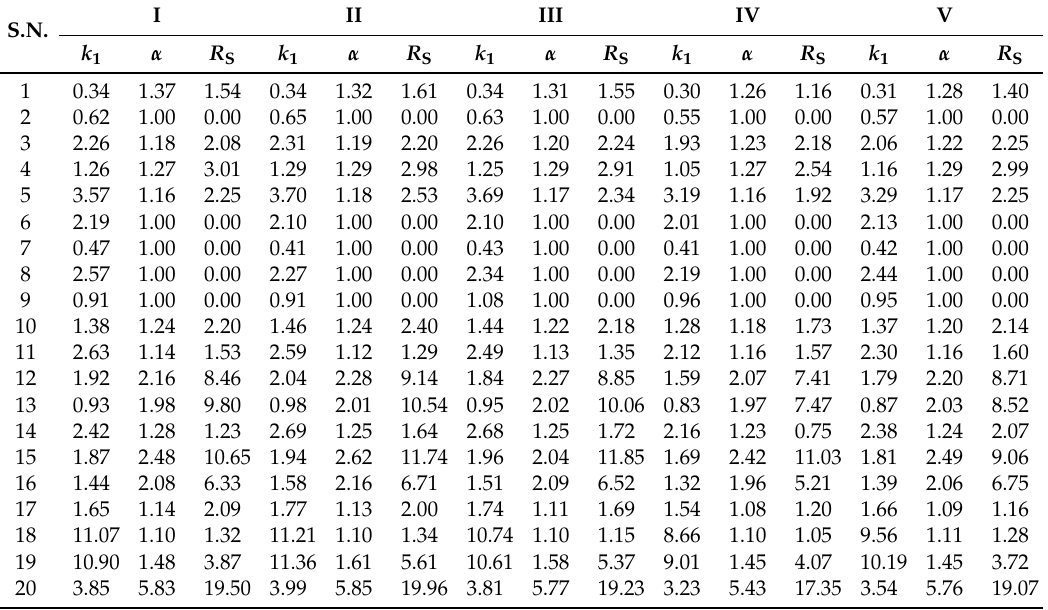
Table 2. The enantioseparation of CSP 5 under different